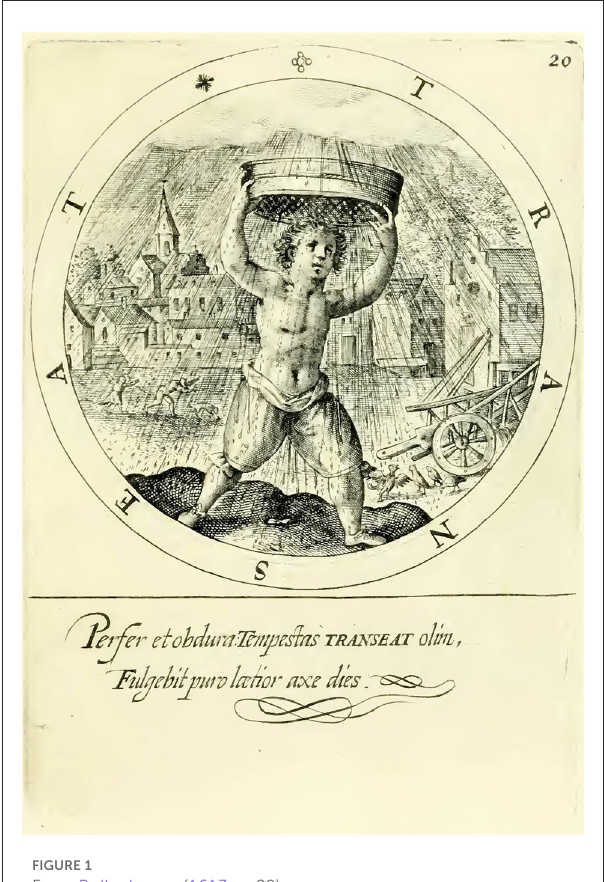
FIGURE1 From Rollenhagen (1613, p.